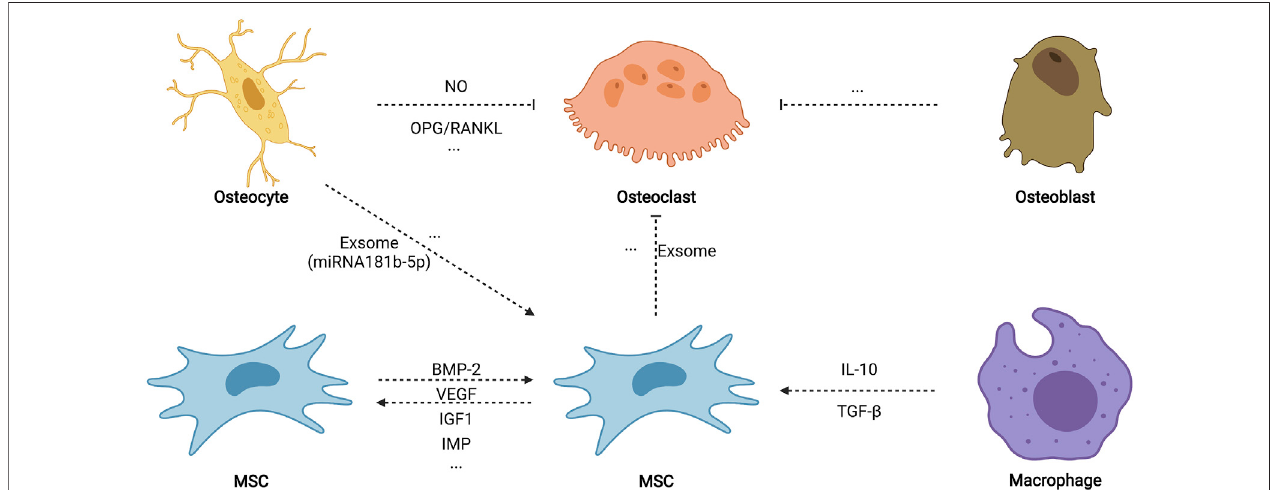
FIGURE 6 | Cell – cell biophysical transduction for MSC osteogenesis: indirect autocrine and paracrine. Indirect cell – cell biophysical transduction is mainly induced by the autocrine and paracrine network. Under biophysical stimuli, MSCs may sensitively secret some autocrine proteins to promote osteogenesis, including BMP-2, VEGF, IGF1, TGF- β , and MIF. MSCs also secrete paracrine factors (such as exosome) to inhibit osteoclastogenesis. Osteocytes release nitric oxide (NO) and relatively more osteoprotegerin (OPG) than NF- κ B ligand (RANKL) to impede osteoclastogenesis. Paracrine factors from osteoblasts also diminish osteoclastogenesis. Moreover, paracrine factors (such as exosome containing miRNA181b-5p) stimulate the osteogenic differentiation of MSCs. Biophysical stimuli also stimulate macrophage (phenotype 2) to promote MSC osteogenesis. Created with BioRender.com.